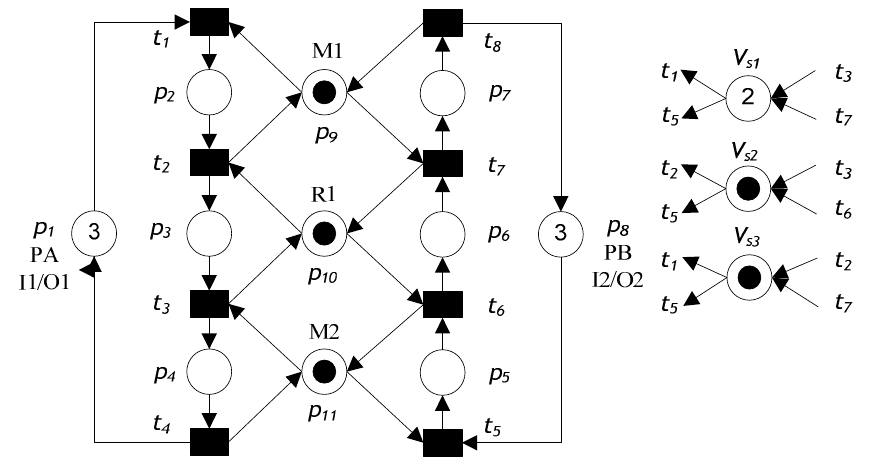
Figure 2. Controlled S 3 PR Petri net model.